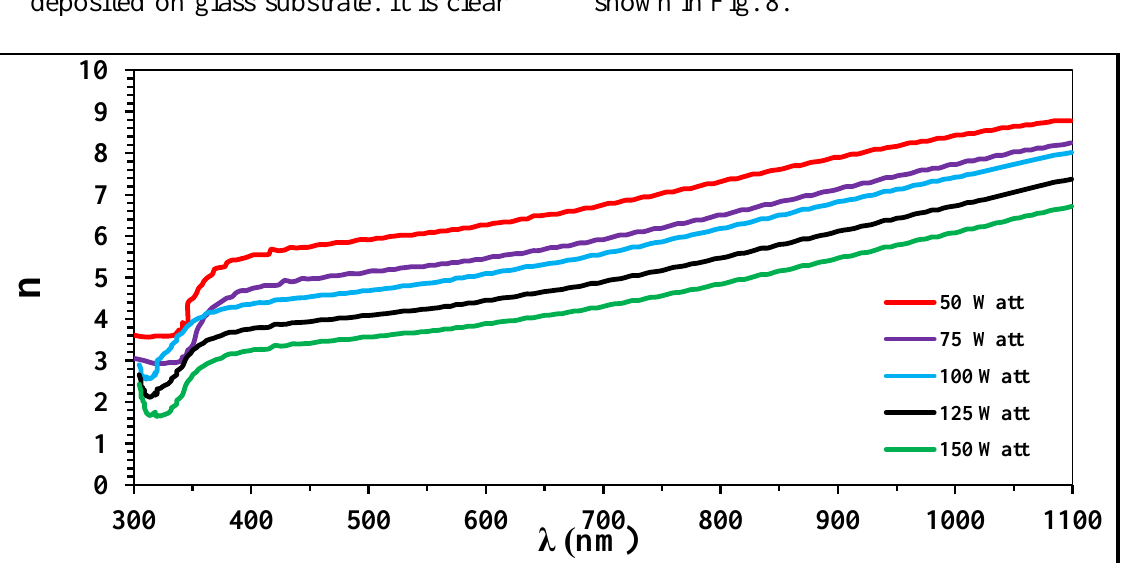
Fig. 8: Refractive index as a function of wavelength for (Ti6Al4V) thin film at different working RF